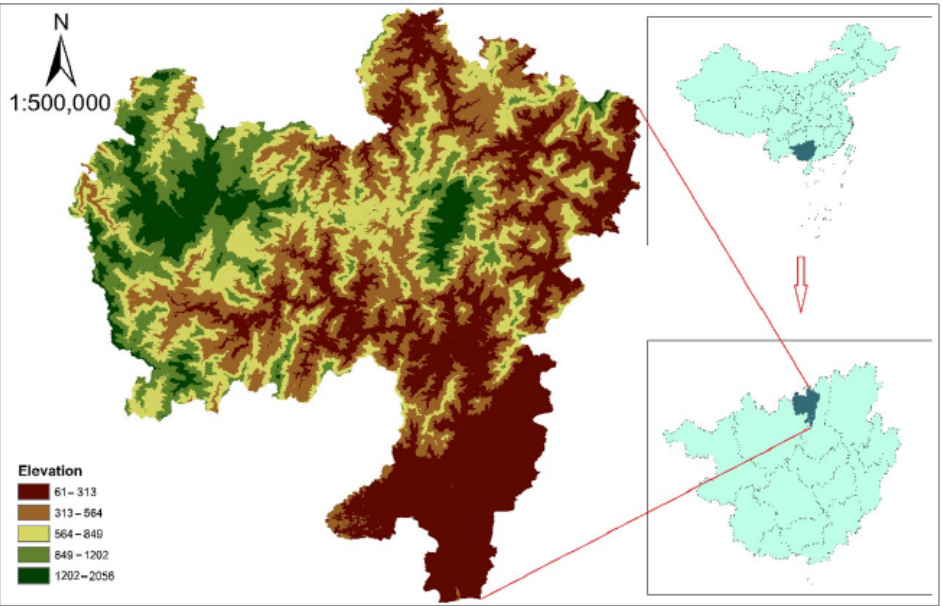
Figure 1. Location of the study area. Geographical Spatial Distribution of Rongshui County, Guangxi Zhuang Autonomous Region. Notes: the elevations are graded in the